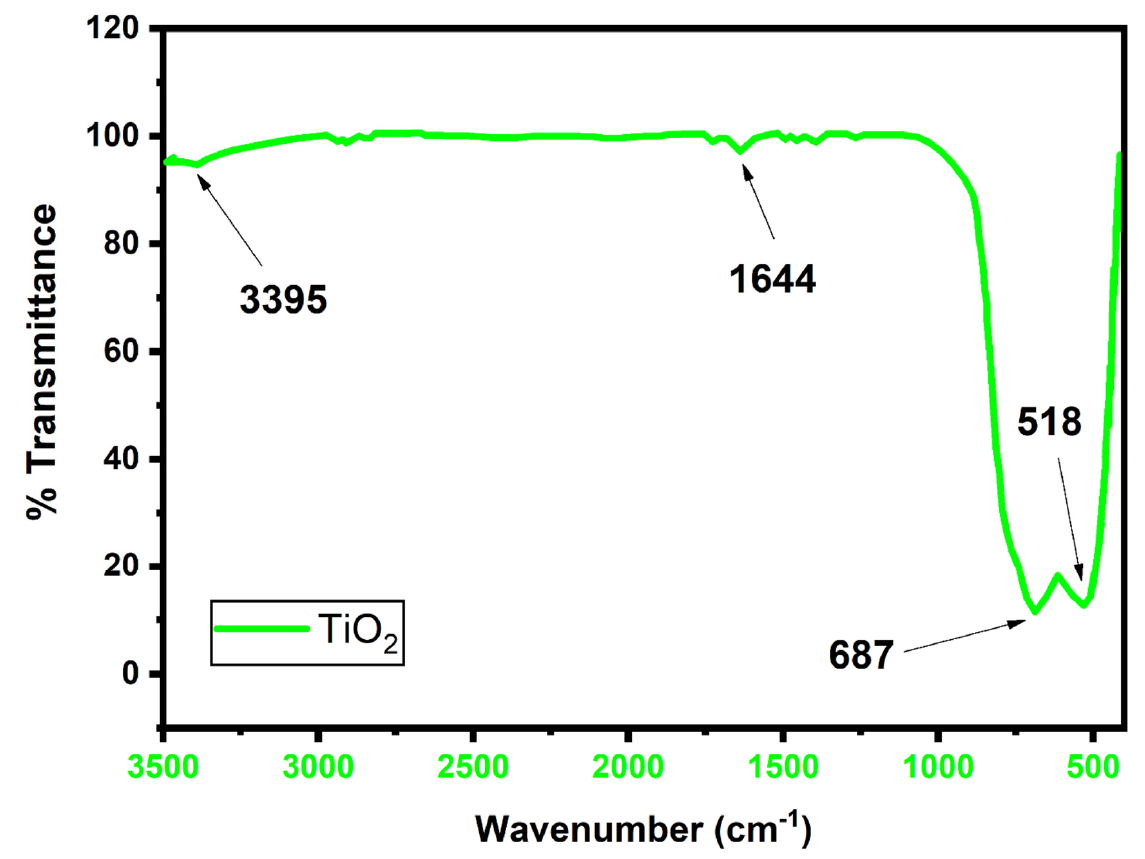
Figure 4. Spectrum obtained from FT-IR analysis of TiO2-NPs.